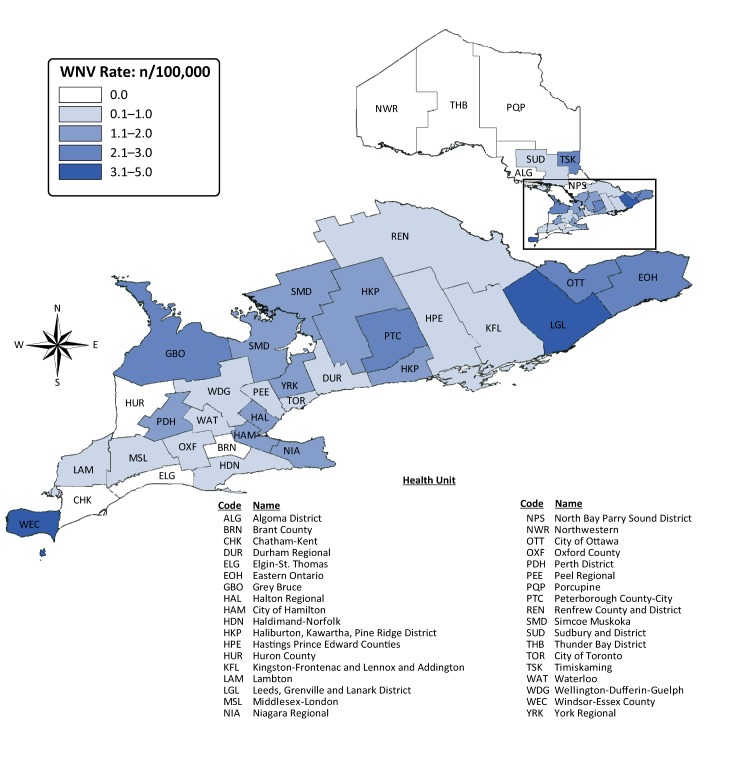
Incidence of West Nile virus illness (per 100,000 population) in 2017, by public health unita, Ontario, CanadaAbbreviations: n, number; WNV, West Nile virusa Public health unit refers to the individual’s health unit of residence at the time of illness onset and not necessarily the location of exposure. Location of disease acquisition cannot be attributed to public health unit